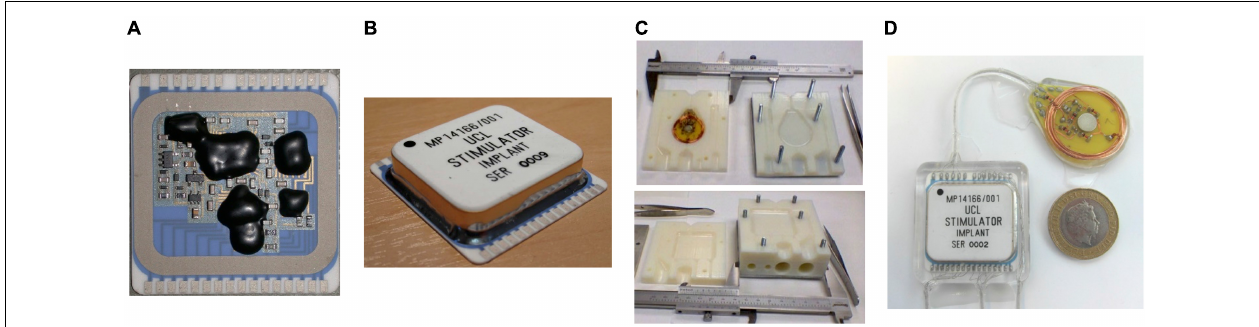
FIGURE 4 | Implant fabrication and encapsulation: (A) Stimulator circuits assembled on a ceramic substrate with the bare dies covered in epoxy glob top; (B) Stimulation circuits hermetically sealed in a metallized ceramic lid; (C) 3D-printed mold for encapsulation: mold for the hybrid (top) and mold for the Rx coil PCB (bottom); (D) fully encapsulated implant with a £2 coin as reference for the size.